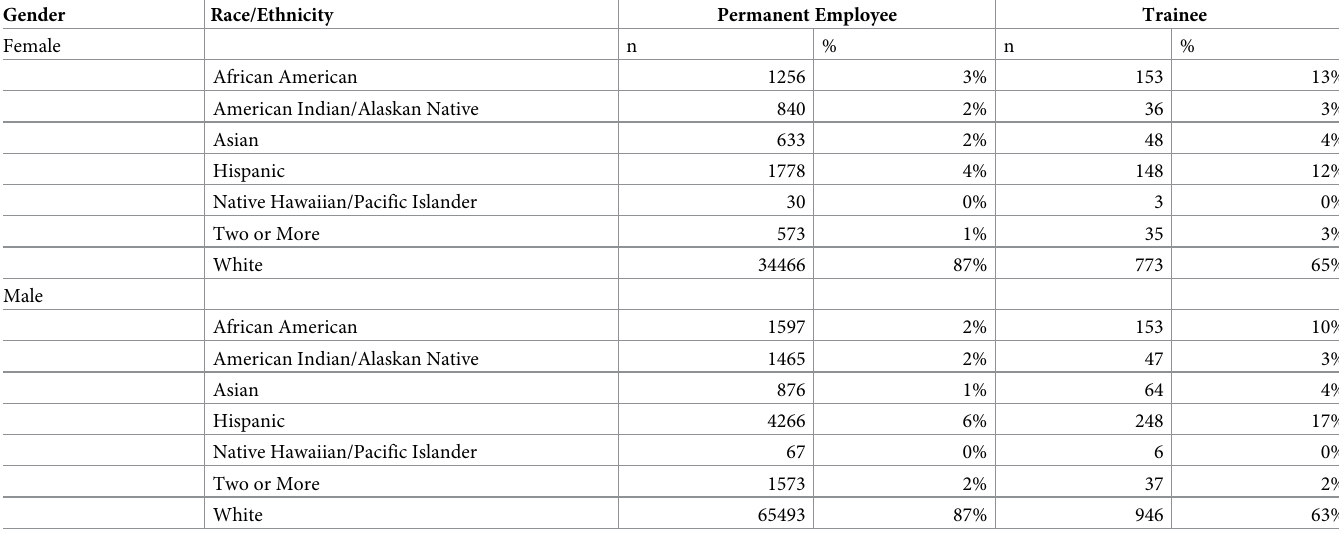
Table 2. Race/ethnicity and gender composition(number and percent) of all USDA forest service employees by permanent and trainee from 1996–2017. Gender